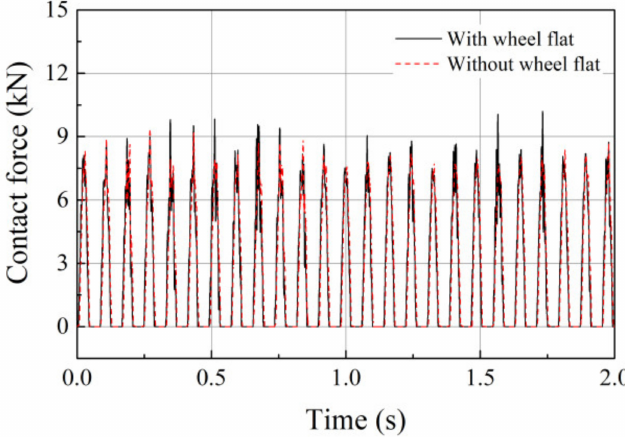
Figure 8. Contact forces between the roller and